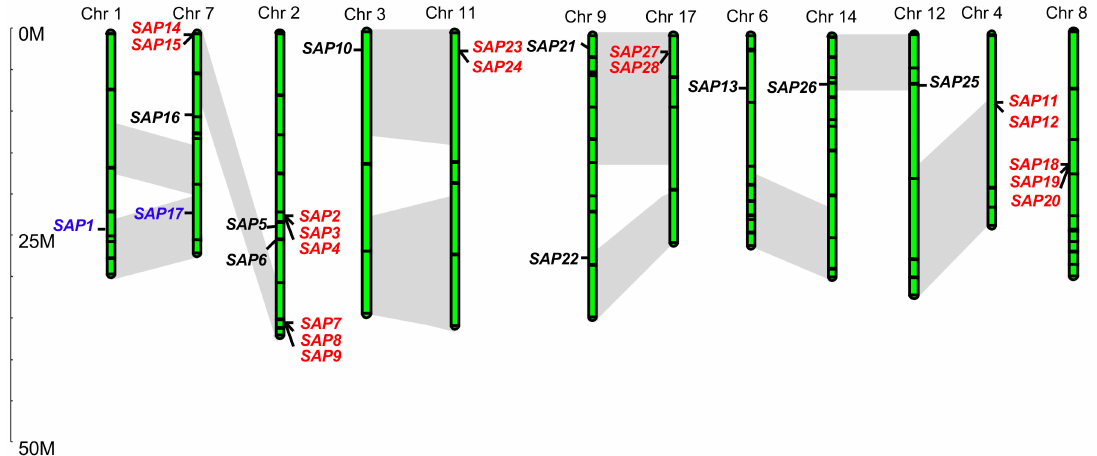
Figure 5. Chromosomal locations of 28 apple SAP genes. Scale is in megabases (Mb). Red font, tandem duplication; blue font, segmental duplication; grey area, genome-wide